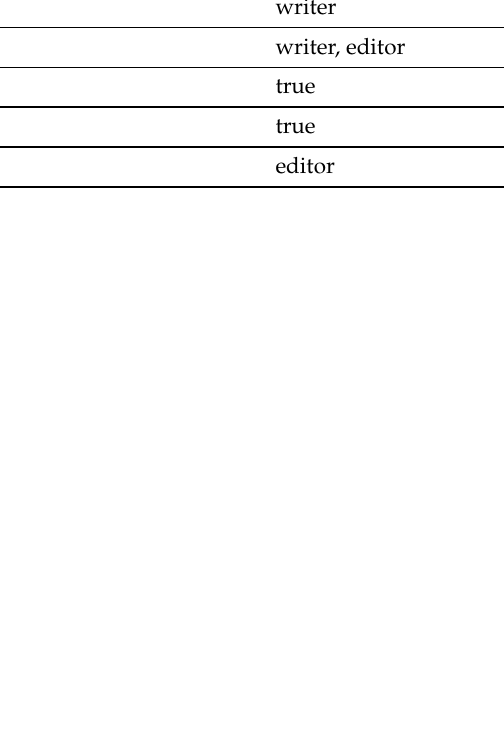
Figure 16. State-space diagram of Writing Paper .